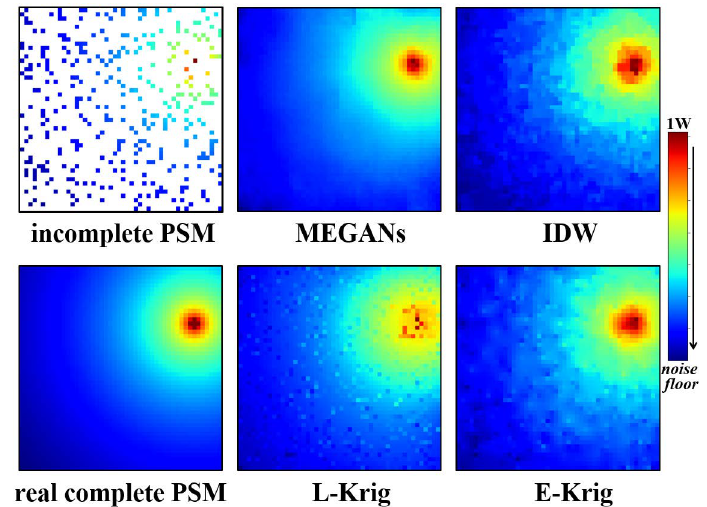
Figure 10. The incomplete PSMs images, MEGANs, IDW interpolation, linear Kriging, exponential Kriging PSMs estimations and the real, complete PSMs images for PU1 at 25 MHz.